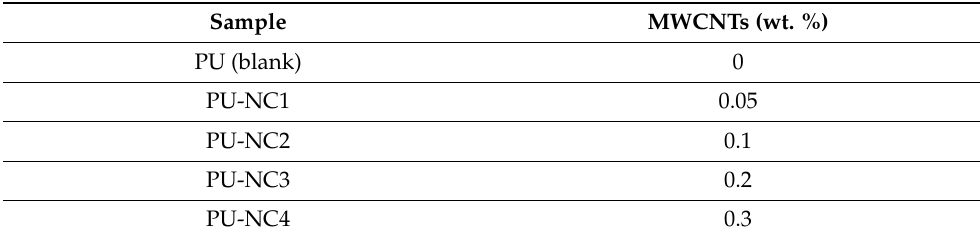
Table 1. The composition of polyurea nanocomposite